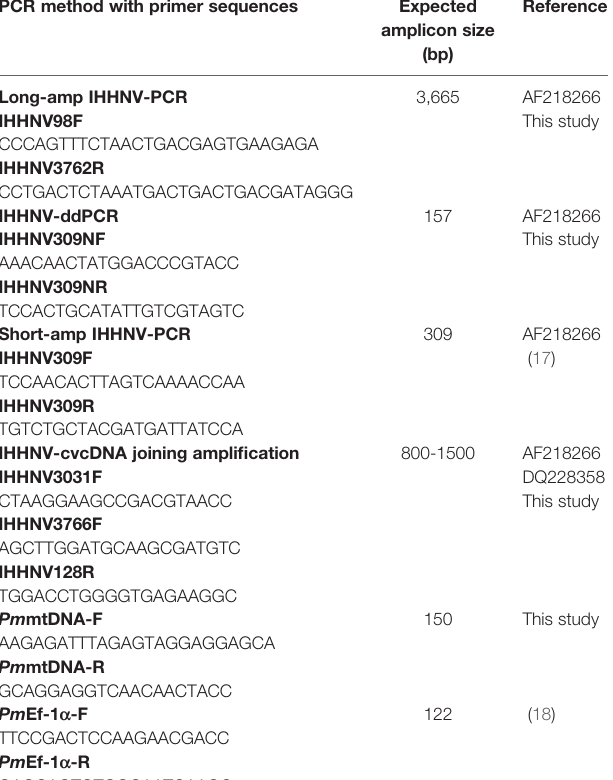
TABLE 1 | List of the primers used in this